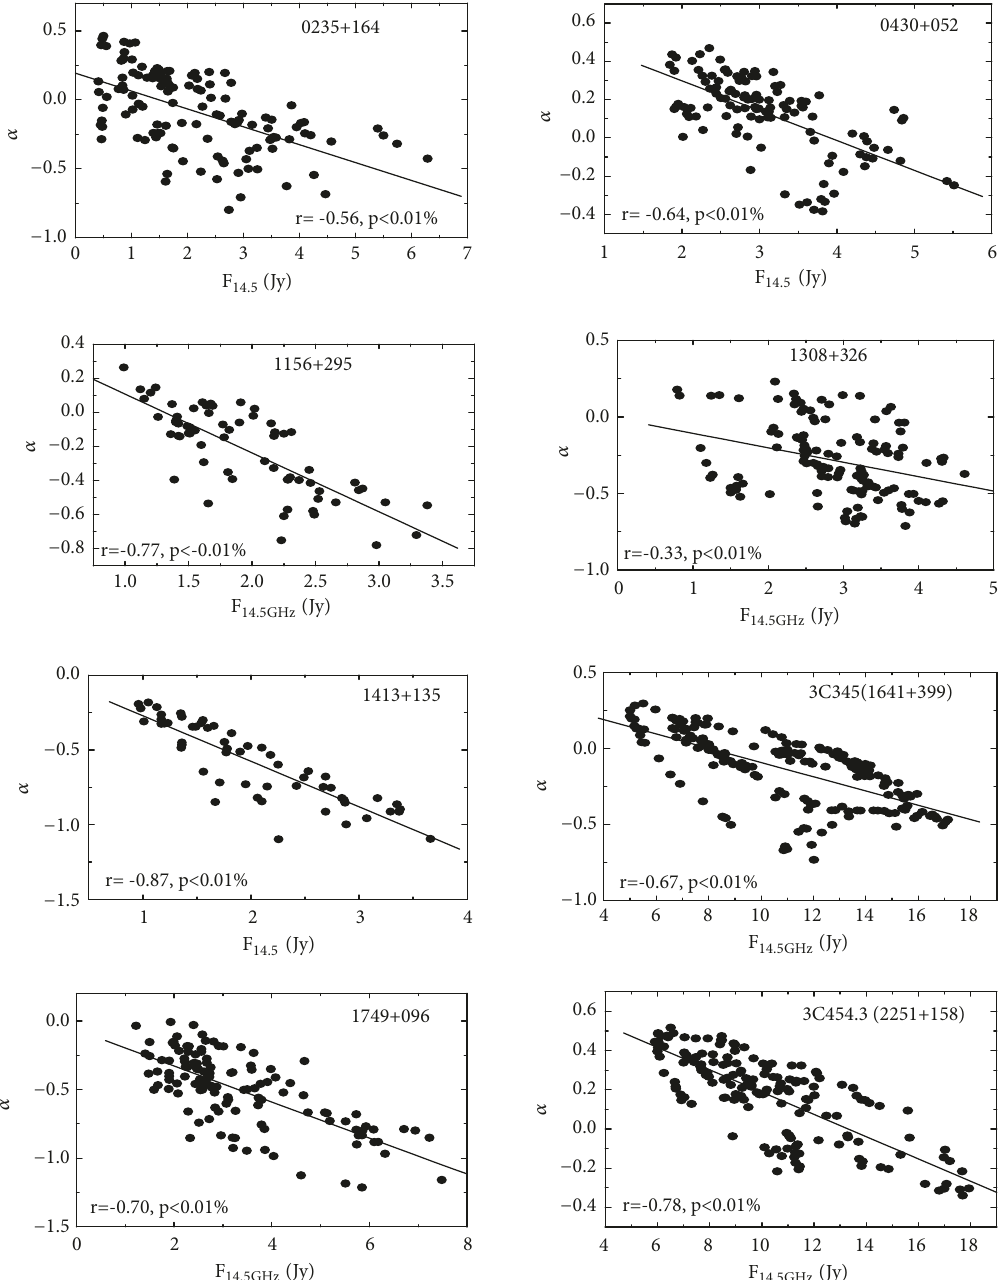
Figure 2: The correlations between the spectral indices ( 𝛼 ) and flux densities ( 𝐹 14.5 ). The solid lines indicate linear fits between 𝛼 and 𝐹 14.5 .